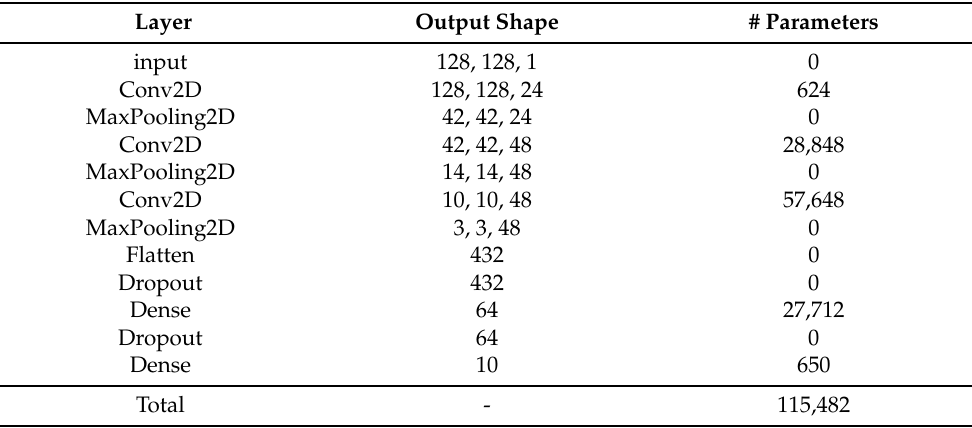
Table 12. Overview of the layers in the modified model